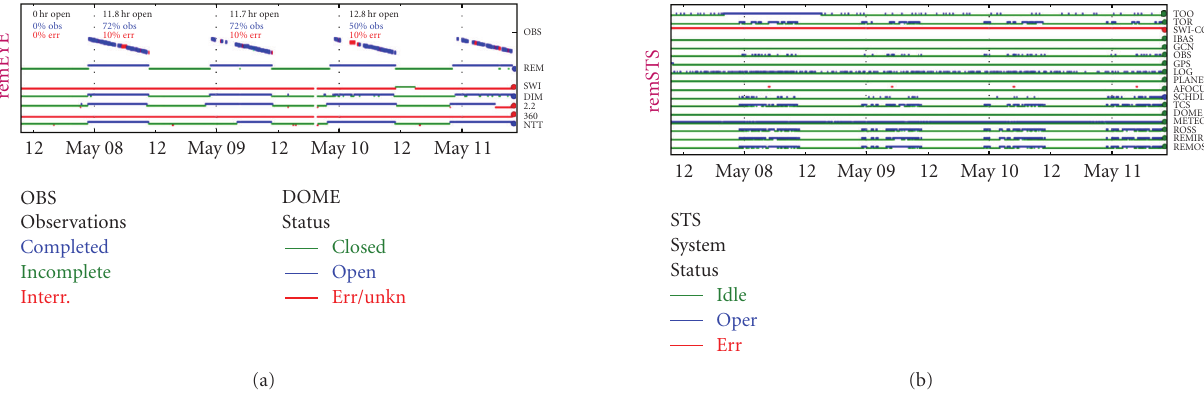
Figure 5: (a) The status of every dome in La Silla is monitored and is used as one of the safety parameters we include in our opening decision algorithm. Also an automatic statistics is computed after each night in order to keep track of real night length (useful for meteo + technical downtime statistics) as well as the e ff ective use of the open time. Percentages report shutter-open time in the night. Errors (in red) are noncompleted observing blocks that need to be repeated. (b) The log of every subsystem status.